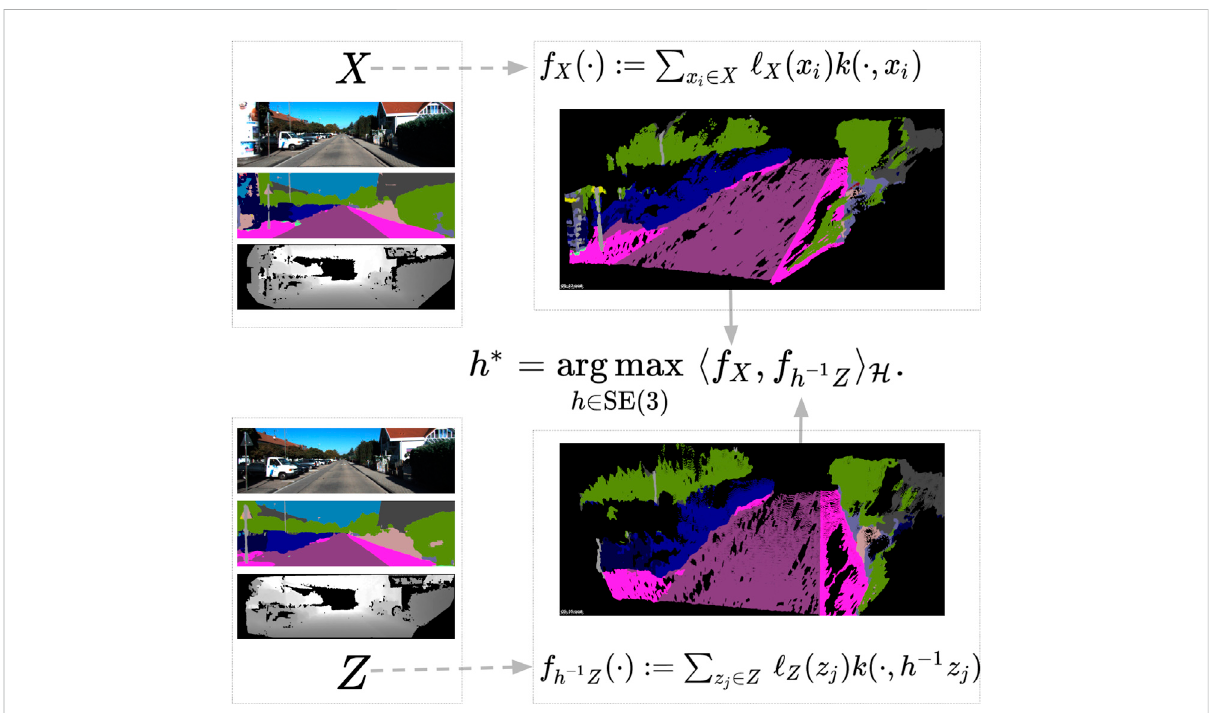
FIGURE 1 Point clouds X and Z are represented by two continuous functions f X , f Z in an RKHS. Each point x i has its own semantic labels, ℓ X ( x i ), encoded in the corresponding function representation via a tensor product representation (Zhang et al., 2021). The registration is formulated as maximizing the inner product between two point cloud